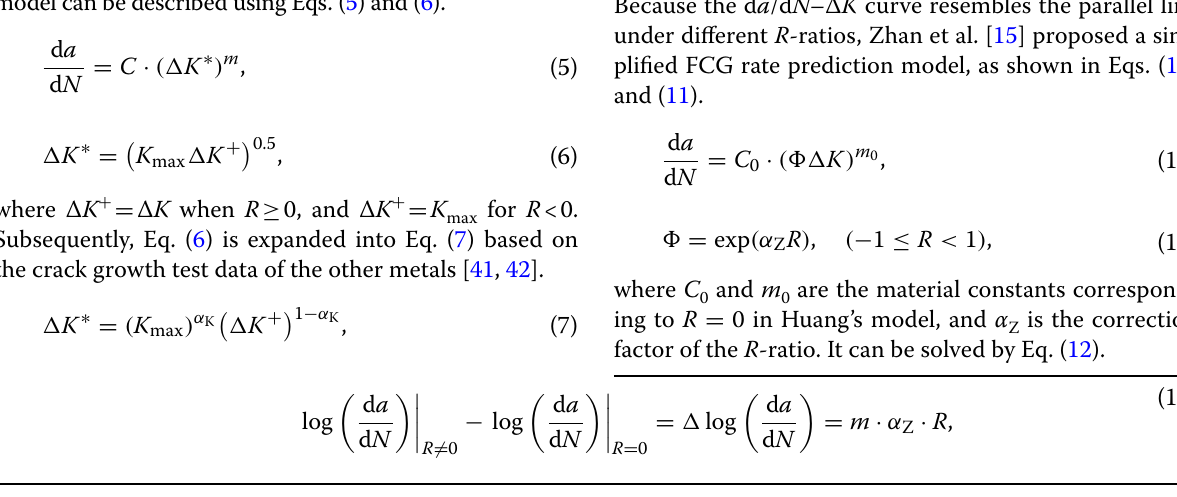
Because the d a /d N –Δ K curve resembles the parallel line under different R -ratios, Zhan et al. [15] proposed a sim- plified FCG rate prediction model, as shown in Eqs. (10) and